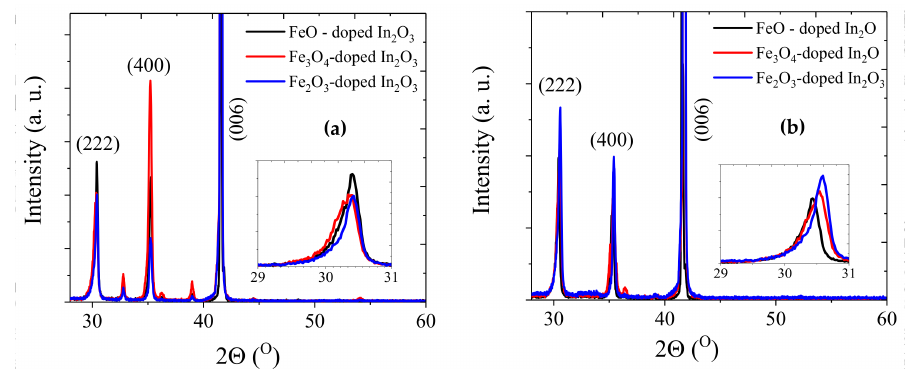
Figure 1. XRD data of the Fe-doped In 2 O 3 thin films grown from di ff erent oxide precursors at ( a ) base pressure of 2 × 10 − 5 Torr and ( b ) 2 × 10 − 3 Torr. The insets demonstrate the e ff ect of the precursor on the position of the (222) peak.